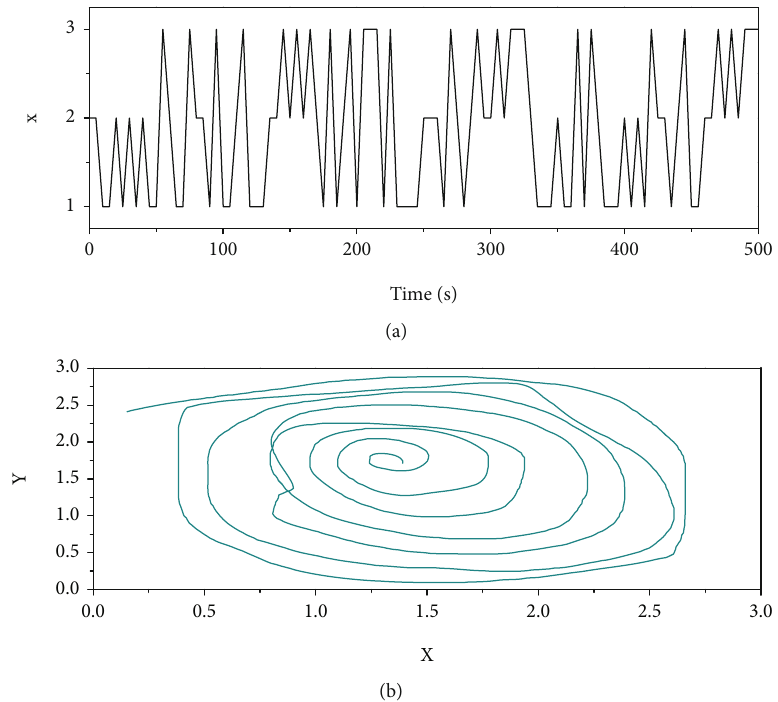
Figure 1: Phase trajectory of the Du ff erin